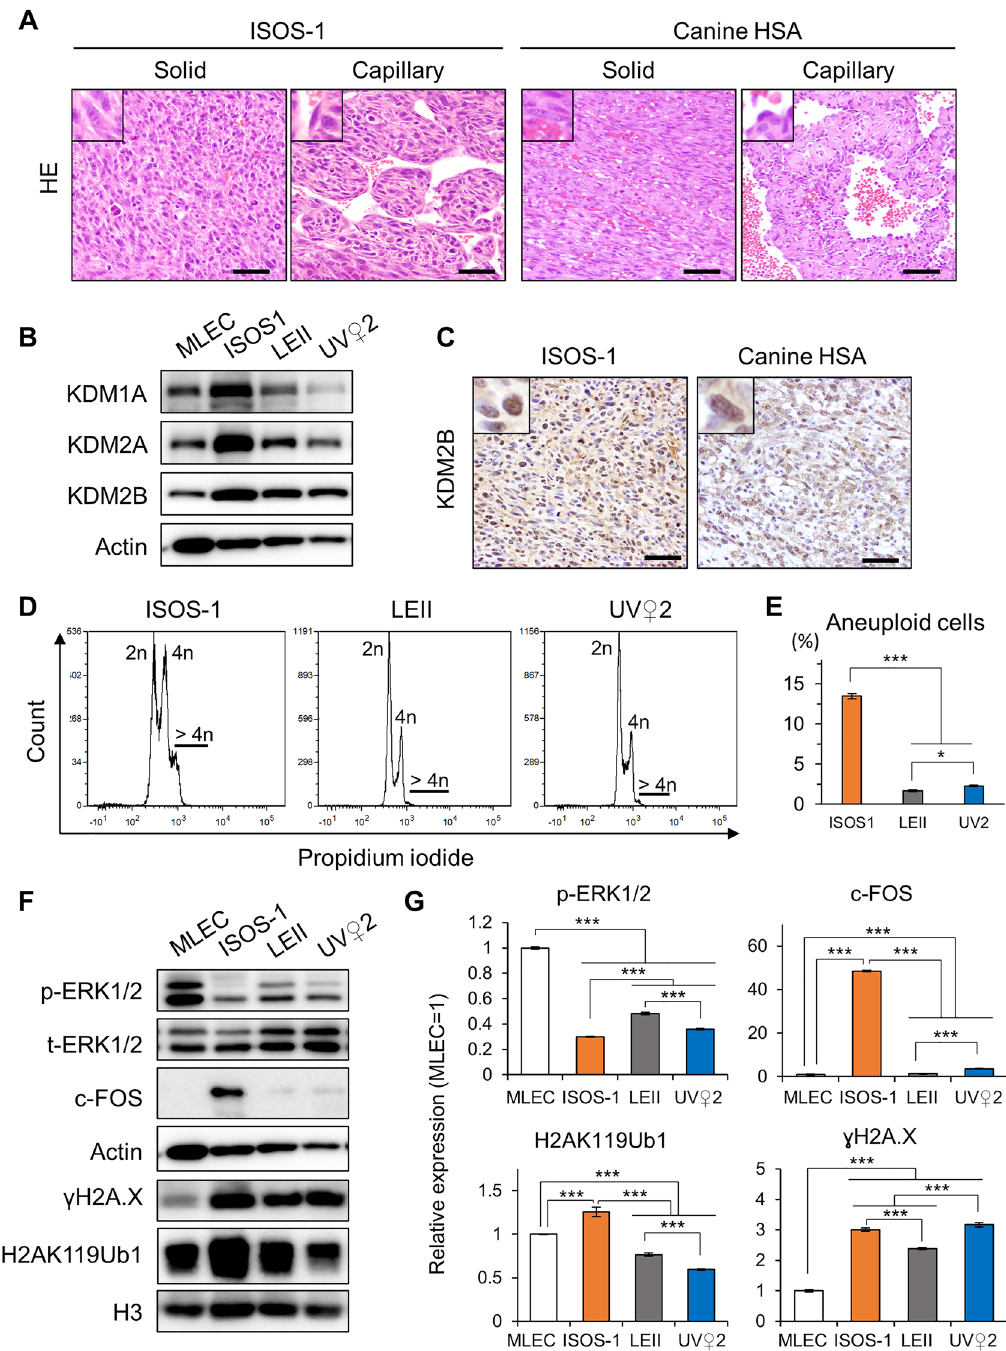
Figure 1. ISOS-1 presents similar morphology and molecular features with canine HSA. ( A ) Hematoxylin and eosin (HE) staining in ISOS-1 and canine HSA tumors. ( B ) KDM1A, KDM2A, and KDM2B protein expressions in MLEC, ISOS1, LEII, and UV ♀ 2 cell lines. ( C ) KDM2B immunohistochemistry of ISOS-1 and canine HSA tumors. ( D ) Histograms of PI intensities in ISOS1, LEII, and UV ♀ 2 cell lines. ( E ) Percentages of cells with aneuploidy in ISOS-1, LEII, and UV ♀ 2 cell lines. ( F ) Western blotting for phosphorylated ERK1/2 (p-ERK1/2), c-FOS, γH2A.X and H2AK119ub1 in MLEC, ISOS-1, LEII, and UV ♀ 2 cell lines. ( G ) Quantification of p-ERK1/2, c-FOS, γH2A.X, and H2AK119ub1 in MLEC, ISOS-1, LEII, and UV ♀ 2 cell lines. p-ERK1/2 expression was normalized with total ERK1/2 expression. c-FOS expression was normalized with Actin expression. H2AK119Ub1 and γH2A.X expressions were normalized with H3 expression levels. The protein expression levels in MLEC were set to 1. Data are presented as mean values ± s.d. Experiments were performed in triplicates. Scale = 125 μm. *** P < 0.001, Tukey’s test. Uncropped western blotting data is found in Supplementary Fig.